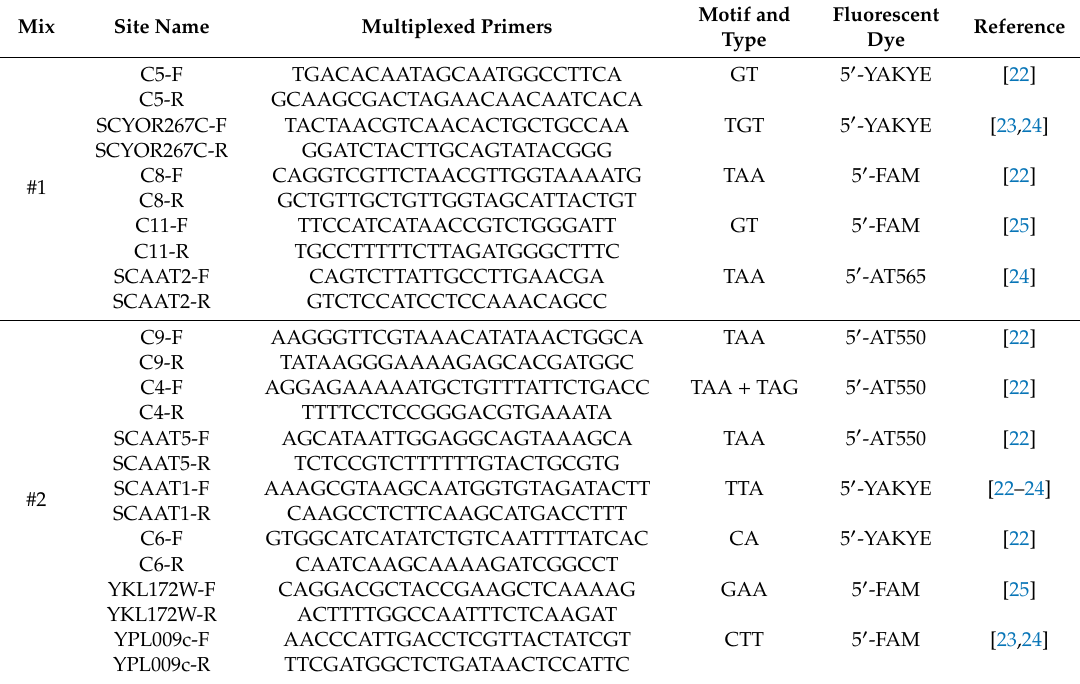
Table 1. Characteristics of the 12 microsatellite loci for the Saccharomyces cerevisiae